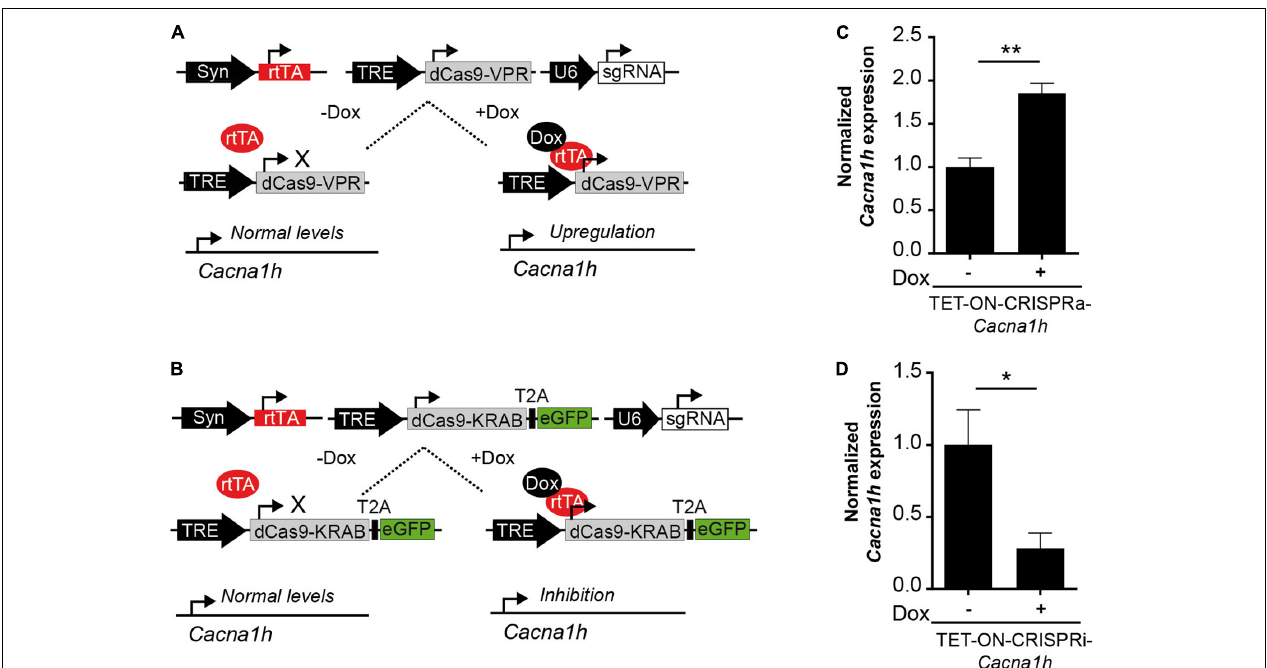
FIGURE 3 | Future perspectives to study Cacna1h -channelopathies. (A) Schematic representation of a TET-ON system for the conditional expression of CRISPRa (TRE-dCas9-VPR). Only in the presence of doxycycline (Dox) the reverse tetracycline-controlled transactivator (rtTA) binds to the tetracycline response element (TRE) inducing the expression of Cacna1h -CRISPRa resulting in augmented endogenous Cacna1h expression. (B) Schematic representation of a TET-ON system for the conditional expression of CRISPRi (TRE-dCas9-KRAB). Only in the presence of Dox, endogenous Cacna1h expression is inhibited. (C) Cacna1h mRNA expression levels of cultured neurons after transduction with the TET-ON-CRISPRa- Cacna1h system (pTRE-dCas9-VPR, pAAV-hSyn-rtTA and pAAV-sgRNA- Cacna1h ) in the presence or absence of doxycycline (1 µ g/mL) ( N = 4, t -test), ** p ≤ 0.01. (D) Cacna1h mRNA expression of cultured neurons after transduction with the TET-ON-CRISPRi- Cacna1h system (pTRE-KRAB-T2A-eGFP, pAAV-hSyn-rtTA, and pAAV-sgRNA- Cacna1h ) in the presence or absence of doxycycline (1 µ g/mL) ( N = 5, t -test), * p ≤